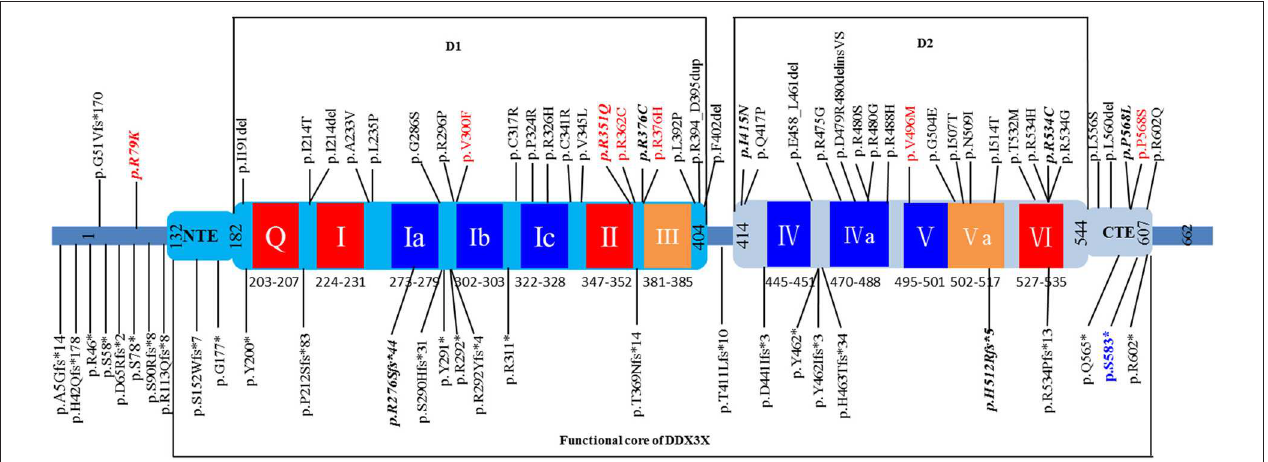
FIGURE 3 | Schematic view of the DDX3X protein structure based on Song et al. (26) showing D1D2, NTE, and CTE fragments. The 12 highly conserved sequence motifs are color coded: red, ATP binding; blue, RNA binding; orange, coordination between ATP and RNA binding. Unique variants (total: 73) are listed in the schematic view, showing the location of the variant identified in our patient (p.S583* in blue). The variants found in affected males are shown in red, and recurrent variants are indicated with bold italics. The 8 splice site variants identified in published cohorts are not shown in this figure.